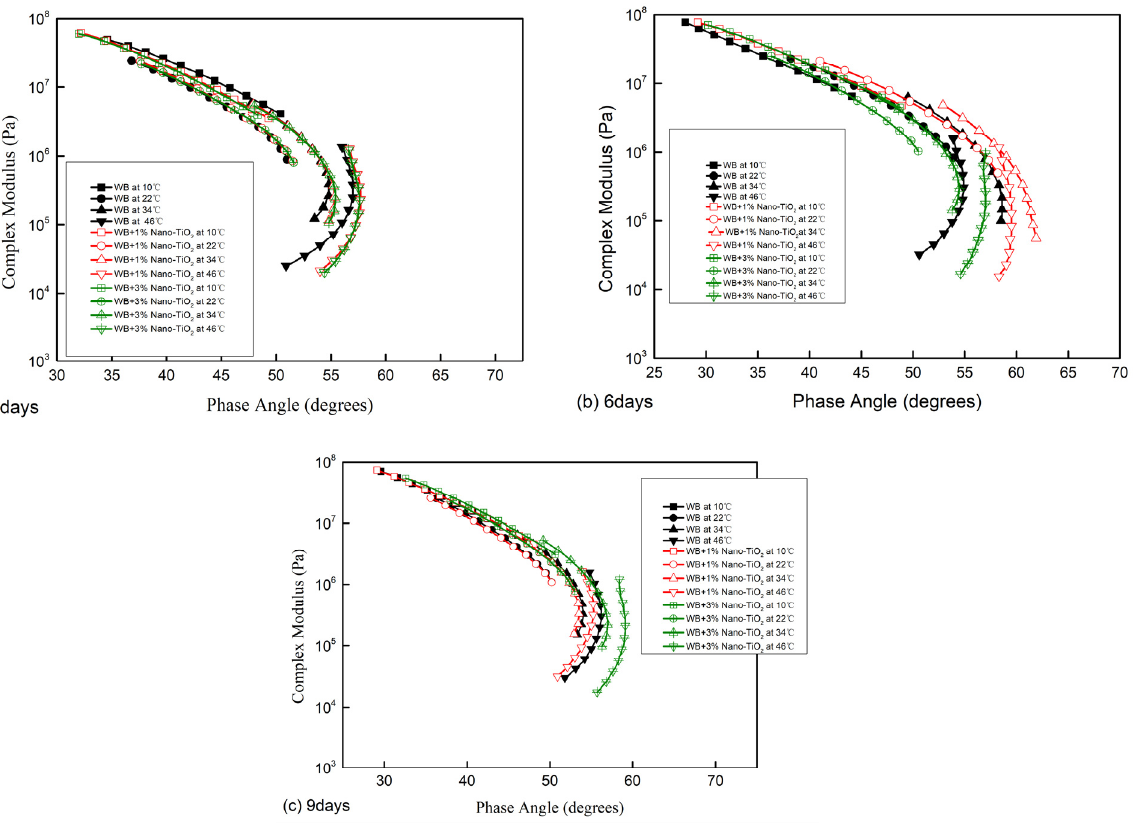
Figure 6. Black diagrams of WB binders with various UV-aging times: ( a ) 3 days; ( b ) 6 days; ( c ) 9 days.